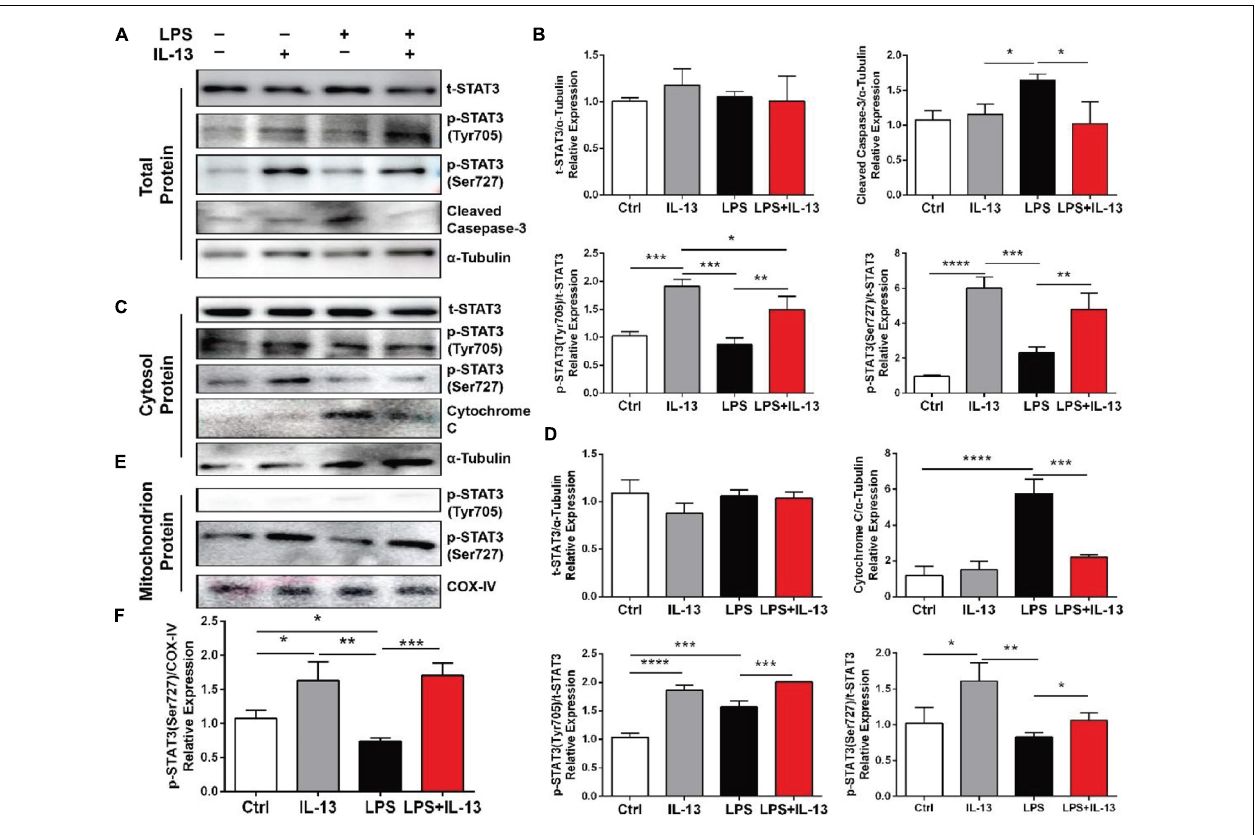
FIGURE 5 | Effect of IL-13 on the phosphorylation of STAT3 in cardiomyocytes. (A) Western blot images of total protein expression. (B) Quantification of (A) . (C) Western blot images of the cytosol protein expression. (D) Quantification of (C) . (E) Western blot images of the mitochondrial protein expression. (F) Quantification of (C) . Data are expressed as the mean ± SD ( n = 3). * p < 0.05, ** p < 0.01, *** p < 0.001, **** p <